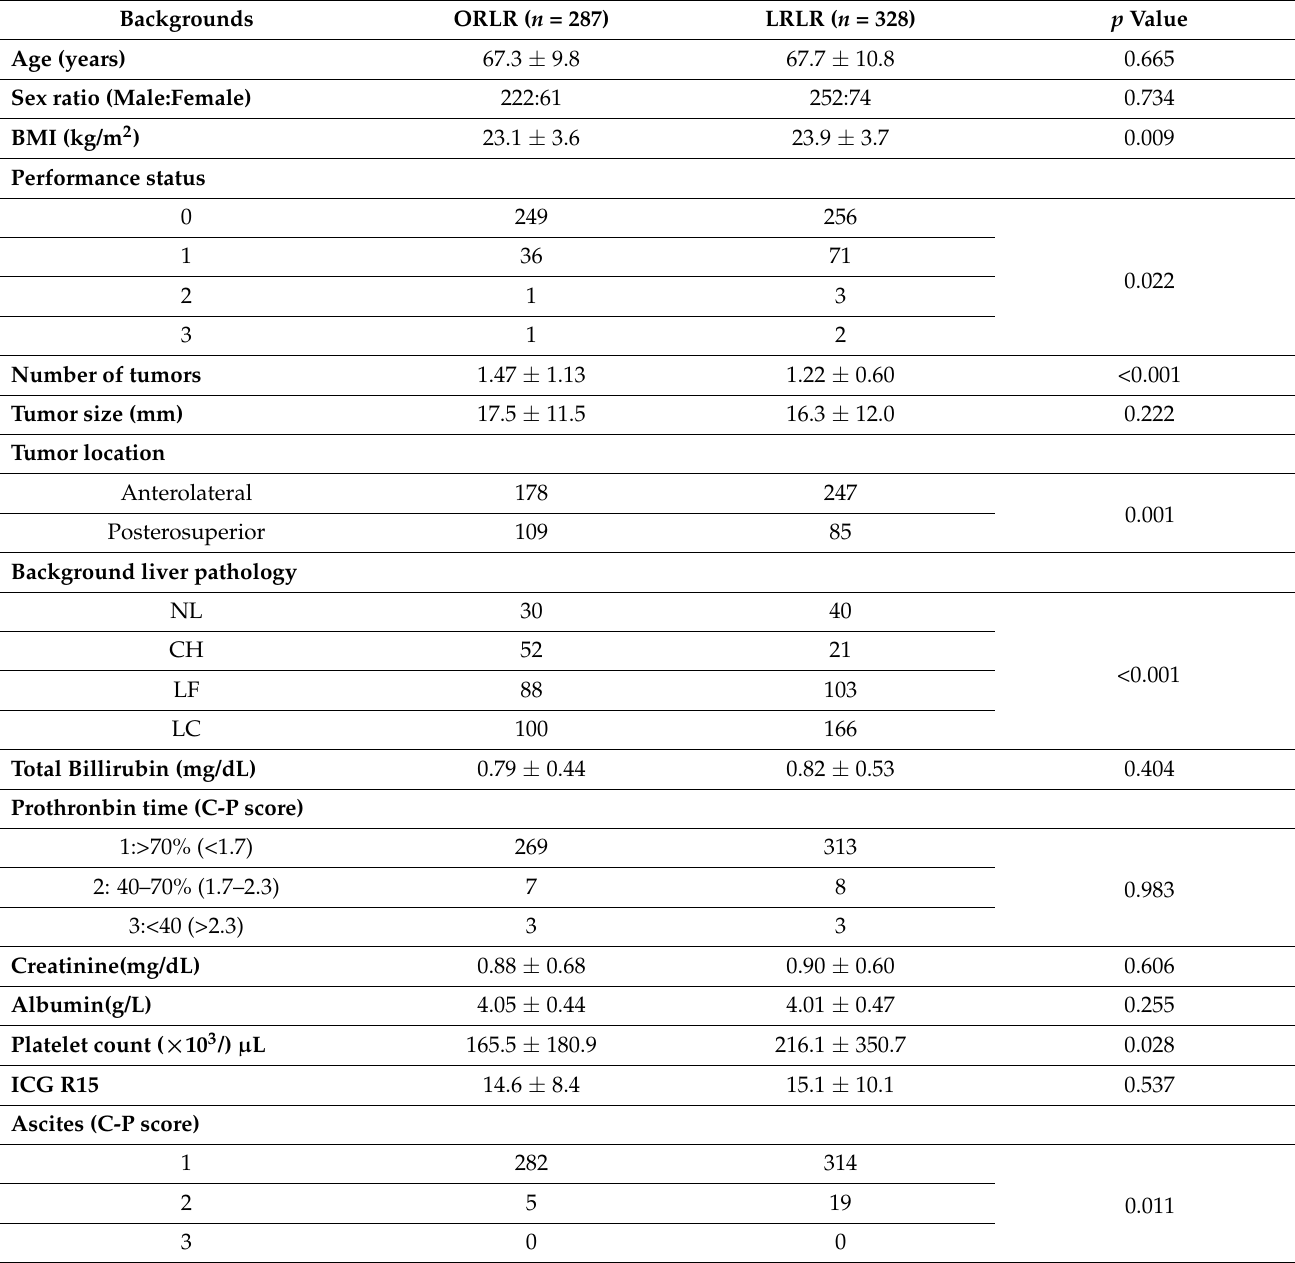
Table 1. Patient and tumor backgrounds before propensity score